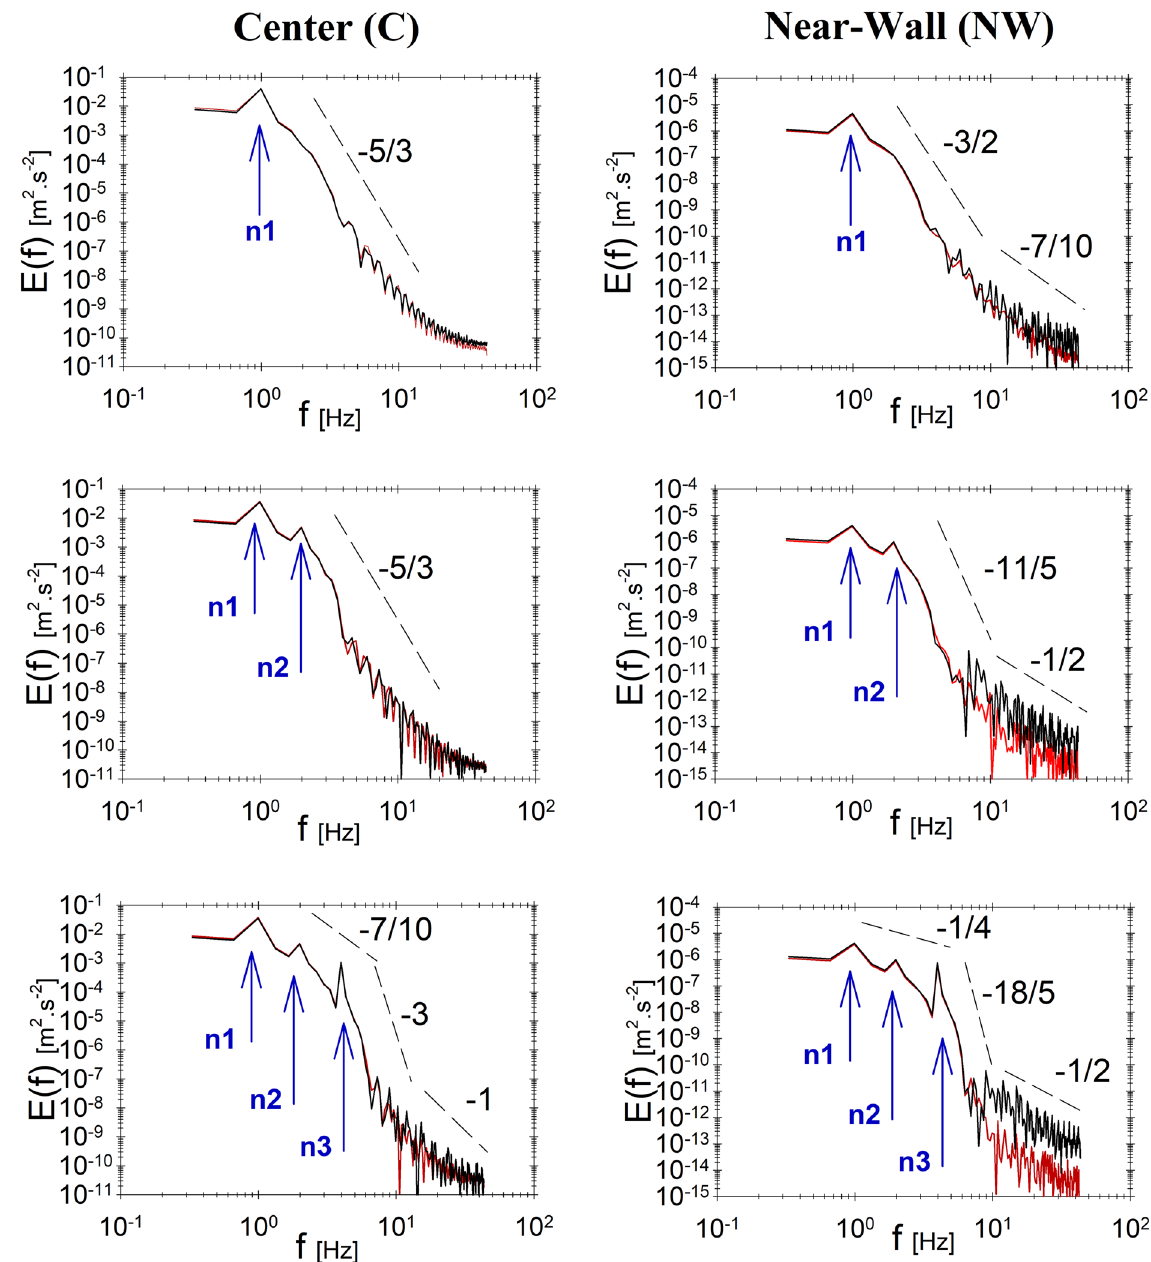
Figure 4. Turbulence Kinetic Energy E(f) cascade in frequency domain (f) at the center point (left column) and 10 µ m near-wall (right column). The depicted cascades present flows with one harmonic (n1), two harmonics (n1,n2) and three harmonics (n1,n2,n3) in the first, second and third rows, respectively. Black and red lines represent Newtonian and non-Newtonian fluids, These iso-volumes represent the near-wall persisting structures that form along the flow domain due to the breakdown on the entrance ring vortex. It is obvious that the effects of local acceleration, as represented by dif- ferent instances (rows, right) of the cardiac cycle, control the vorticity field magnitude. It is also clear that the viscosity (N, CY, sub-rows left) has diminishing effect on the structure and magnitude of the near-wall structures. The number of harmonics affects the vorticity magnitude at the same instance of time ( n = 1, 2, 3 , columns). In minimum diastole, cases 2 N and 2CY exhibit near-zero vorticity field. In mid deceleration, cases 3 N and 3CY have approximately 20% increase in the vorticity magnitude compared to cases 1 N and 1CY.